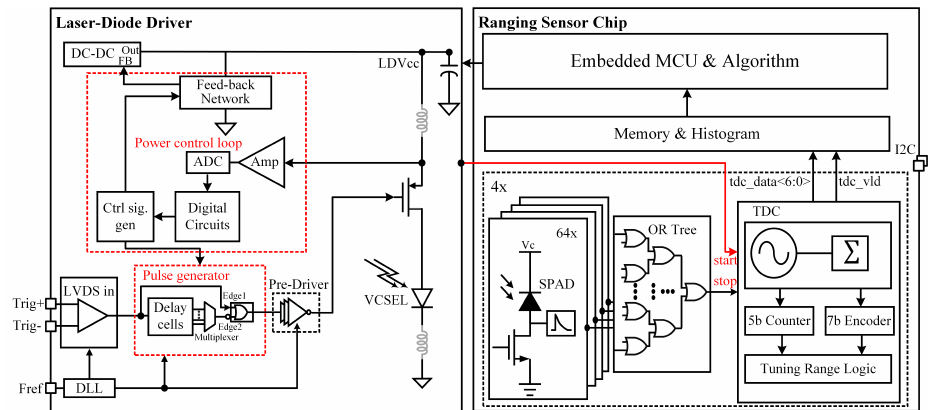
Figure 2. The ranging system with a pulsed VCSEL driver and SPAD-based sensor circuit